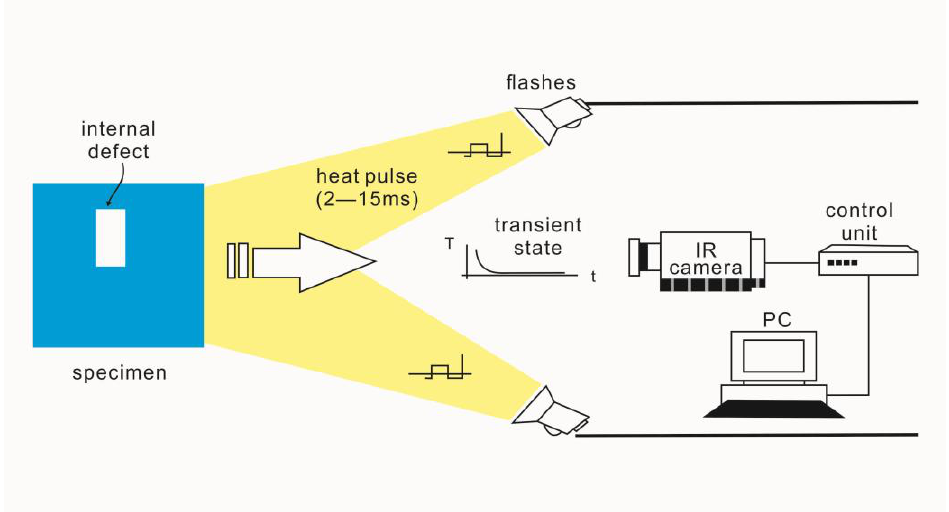
Figure 1. Pulsed thermography experimental setup optical excitation.